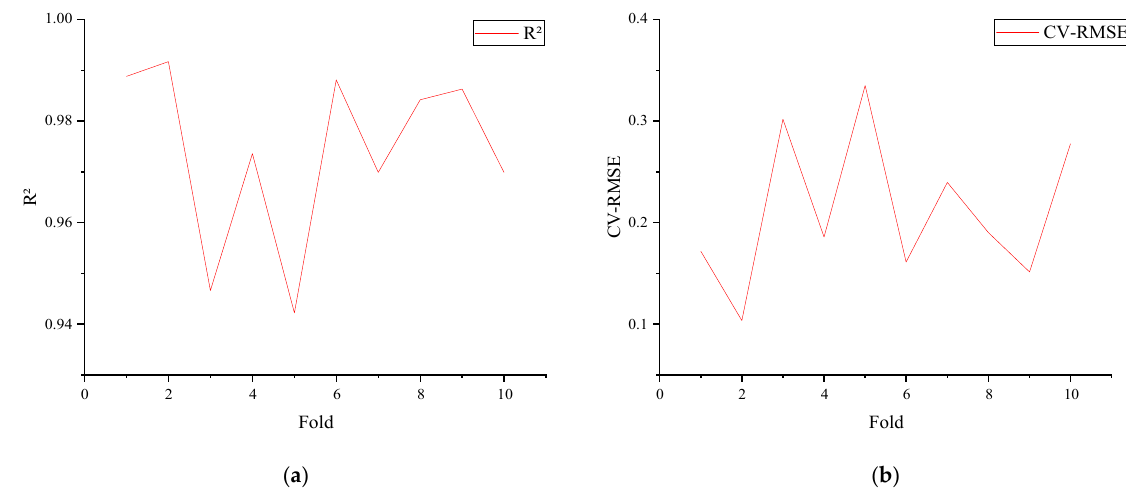
Figure 8. Accuracy index of the Gaussian process regression model with ten-fold cross-validation. ( a ) R 2 . ( b ) CV-RMSE.